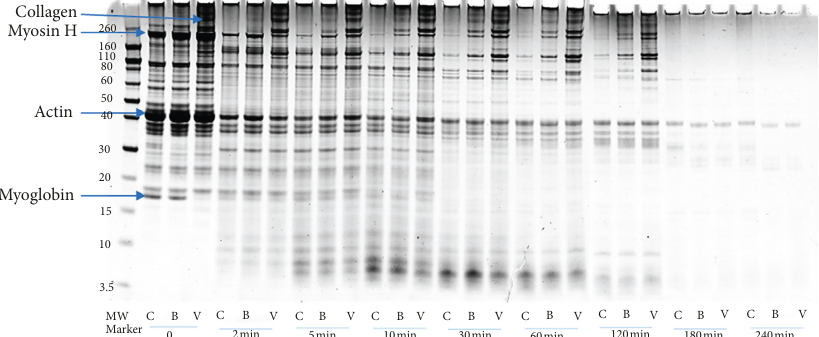
Figure 2: Experiment 1: SDS PAGE showing the effect of age of cattle on the digestibility of protein in cooked semimembranosus from cow (C), bull (B), and calf (veal, V). Results of gastric and intestinal phases for the pooled samples from 7 animals per age are presented as examples.